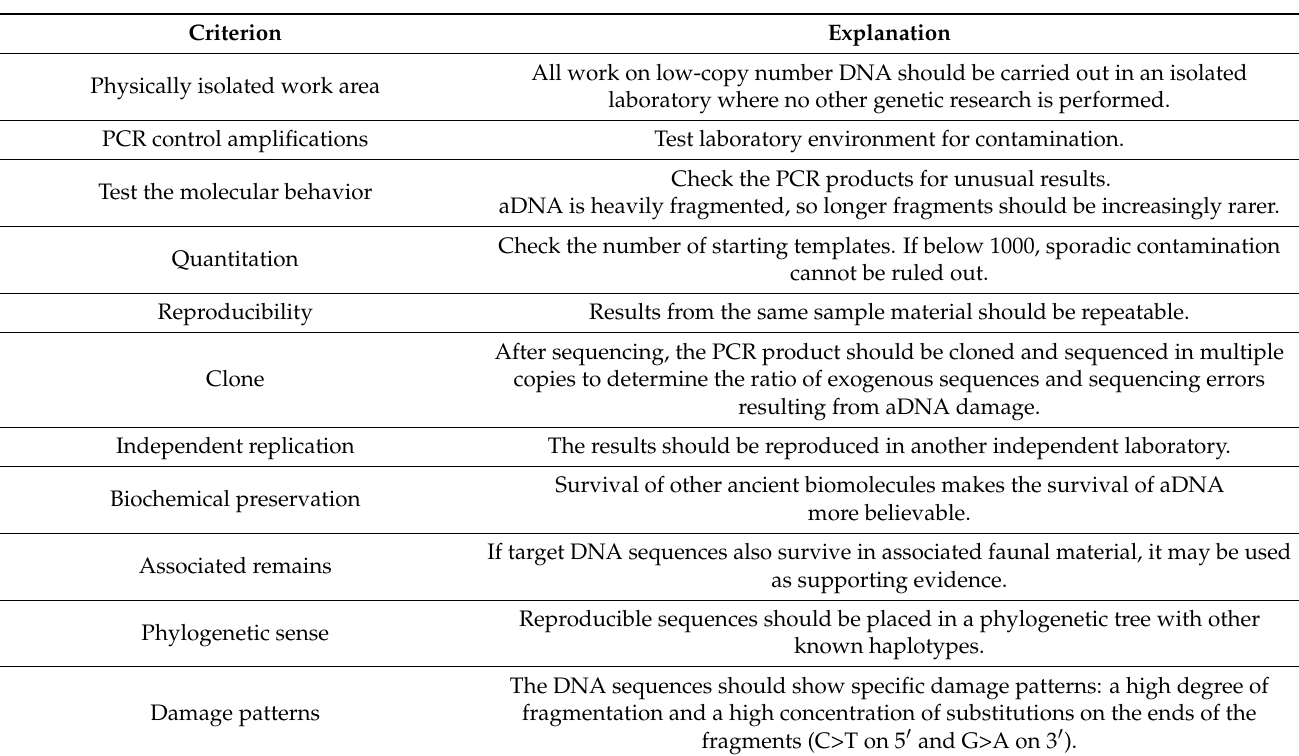
Table 2. Authenticity criteria. The table shows the criteria to follow to ensure that the recovered sequences are indeed ancient and not a result of contamination with modern genetic material